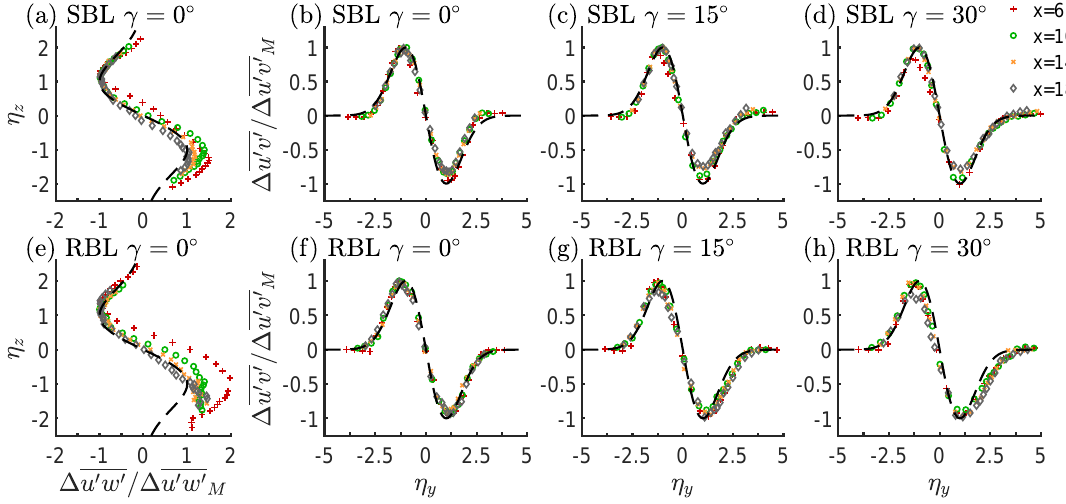
Figure 11. Vertical and lateral profiles of the normalised added Reynolds shear stress ∆ u (cid:48) u (cid:48) r / ∆ u (cid:48) u (cid:48) rM versus η z and η y in the wake of the model wind turbine immersed in the SBL with ( a )/( b ) γ = 0 ◦ , ( c ) γ = 15 ◦ , ( d ) γ = 30 ◦ and in the RBL with ( e )/( f ) γ = 0 ◦ , ( g ) γ = 15 ◦ , ( h ) γ = 30 ◦ . Black dashed line denotes the distribution − η e − 0.5 ( η 2 − 1 ) . The legend indicates the downstream position.